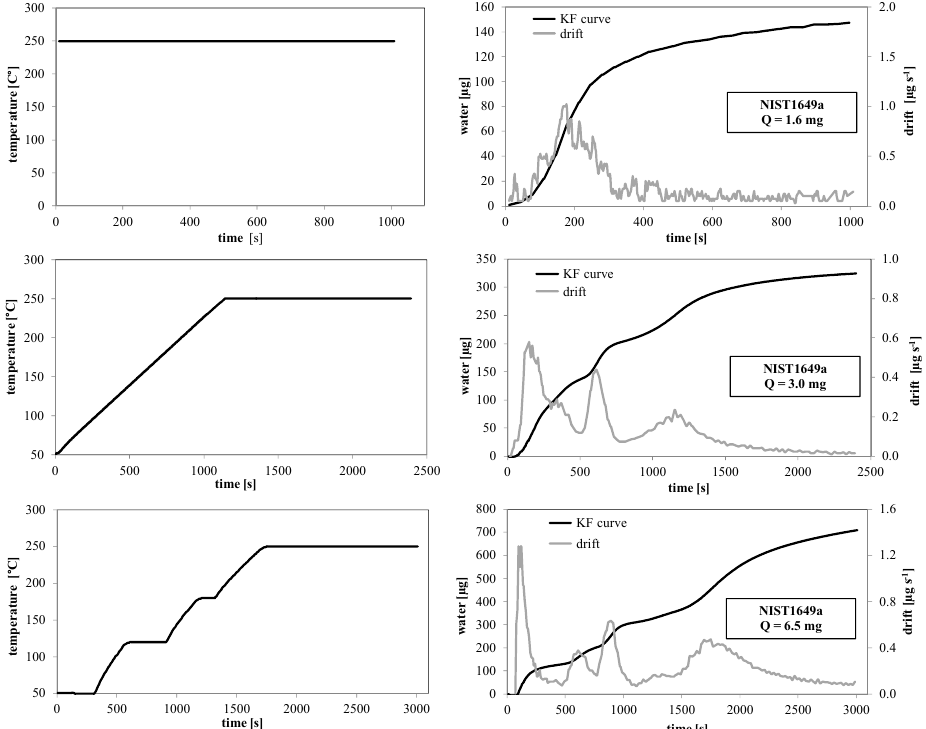
FIGURE 2 Fig. 2. Different thermal ramps (left panels) and resulting Karl-Fisher curves (right panels) for the analysis of Reference Material NIST1649a.